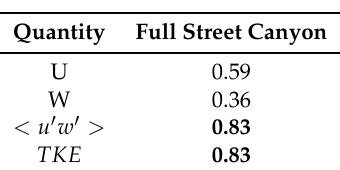
Table 4. Hit rate metric q .